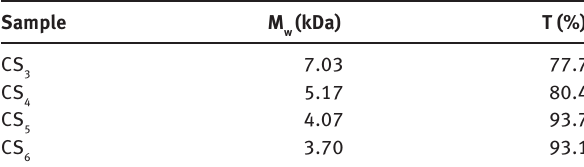
in pure water. 6